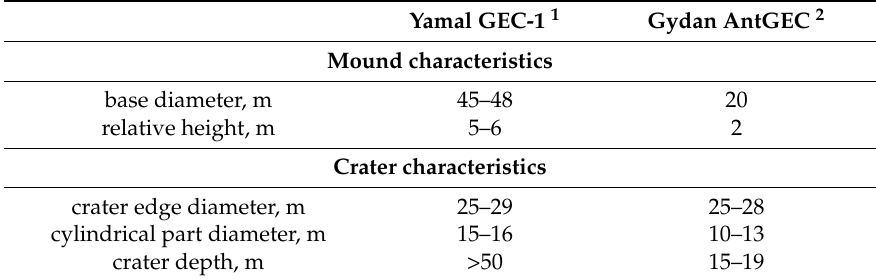
Table 2. Comparison of Yamal GEC-1 and Gydan AntGEC morphometric